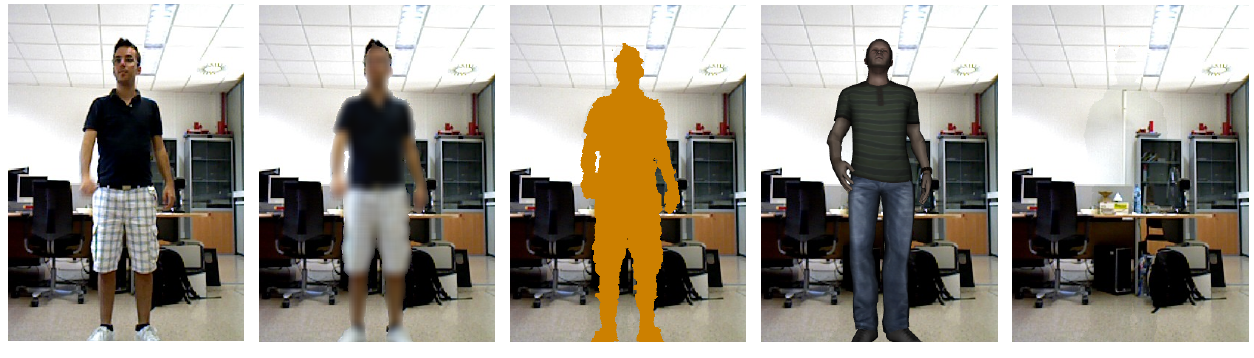
Figure 7. Visualisation models, ordered from lower to higher protection. These images have been obtained by applying the different models to the same video